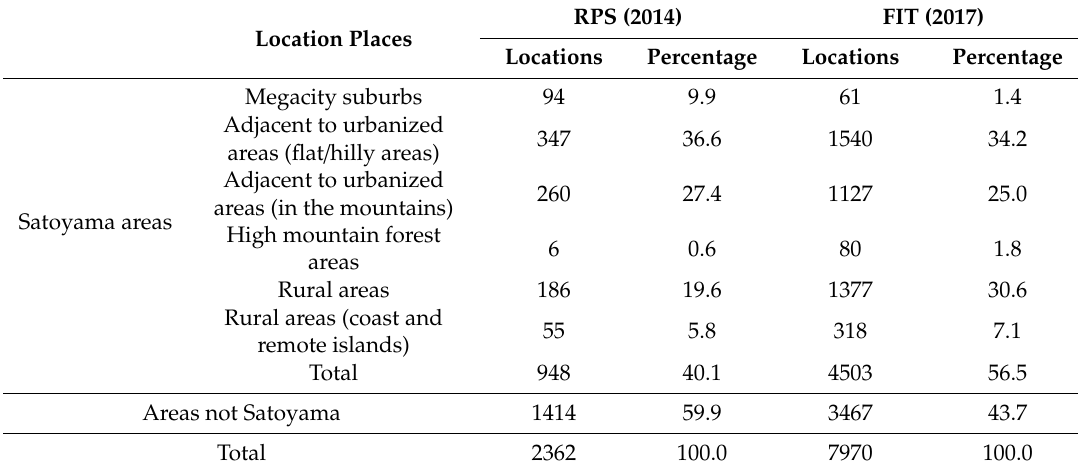
Table 2. Research results: Locations of solar power based on the RPS and FIT in Japan (source: collected and processed by the authors).